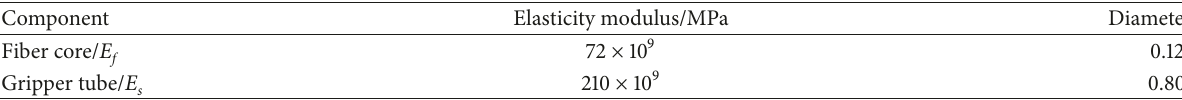
Table 3: Mechanical properties of FBG [34].